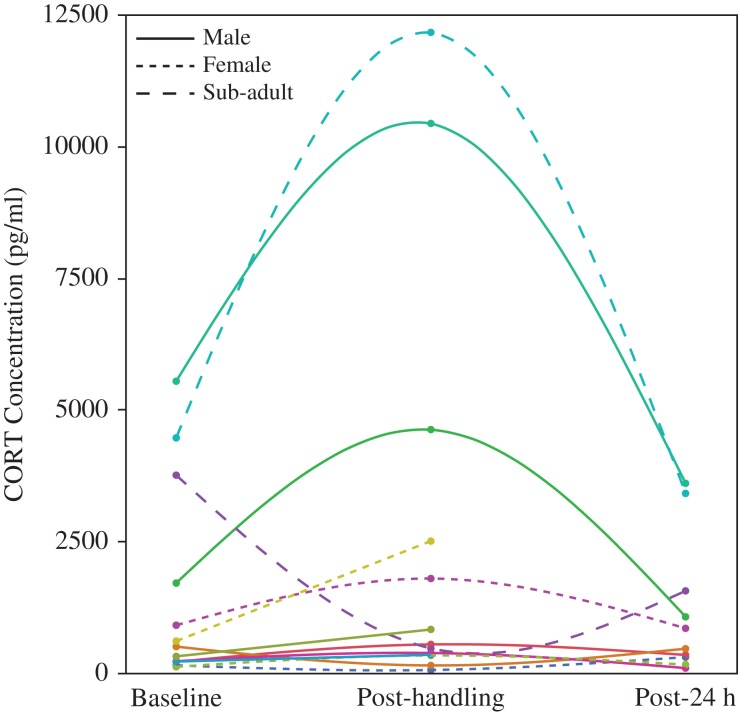
Corticosterone (CORT) concentration measured for each individual Astrochelys radiata at each sample time in February, 2012. Trend lines connect individuals’ samples.